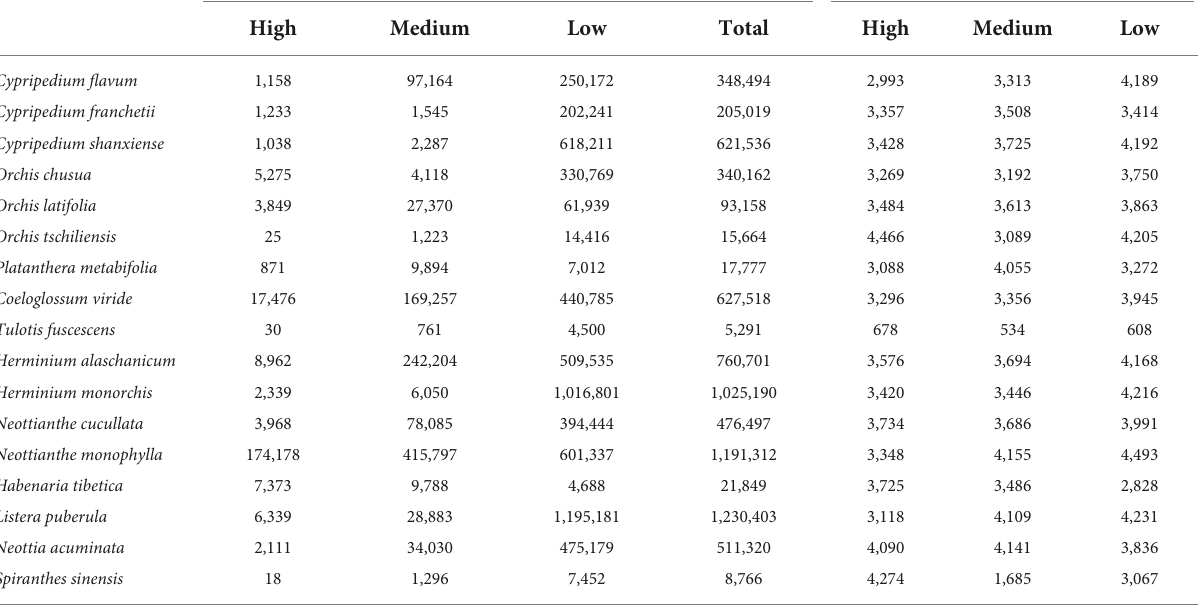
TABLE 4 The area and elevation in potentially suitable habitat for 17 orchid species under current climate